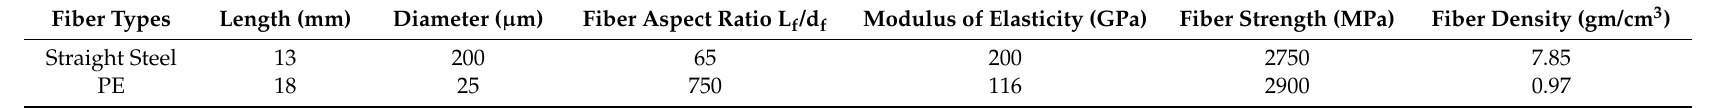
Table 2. Properties of fibers.